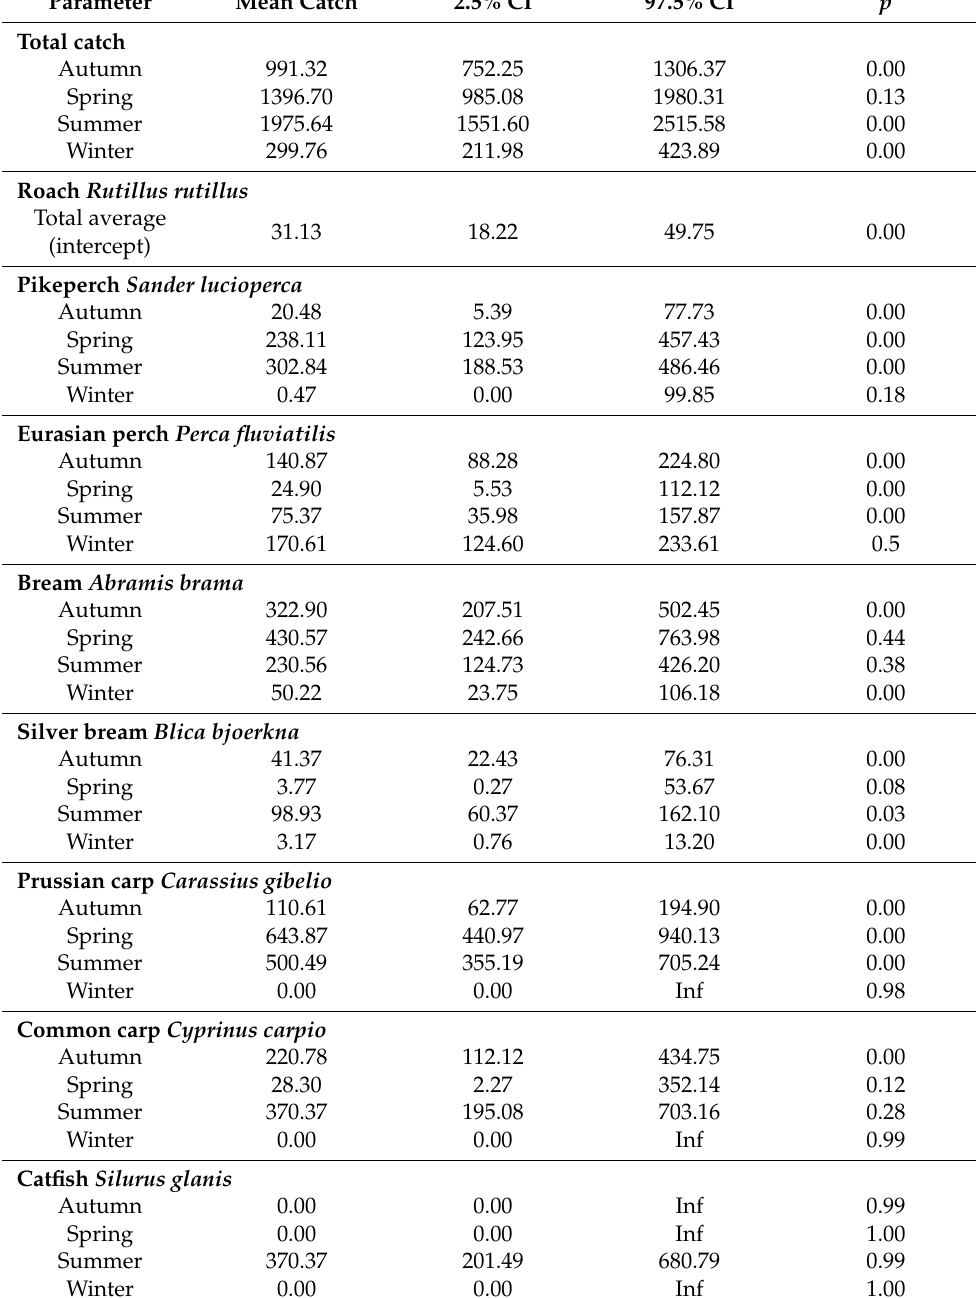
Table 2. Estimated average recreational catch-per-unit-effort (grams per fishing trip) during the study period (2016–2021) and their uncertainty for selected species and season combinations, using data from total number of angling trips and models that included only a random intercept and season (for roach, season was non-significant and therefore not